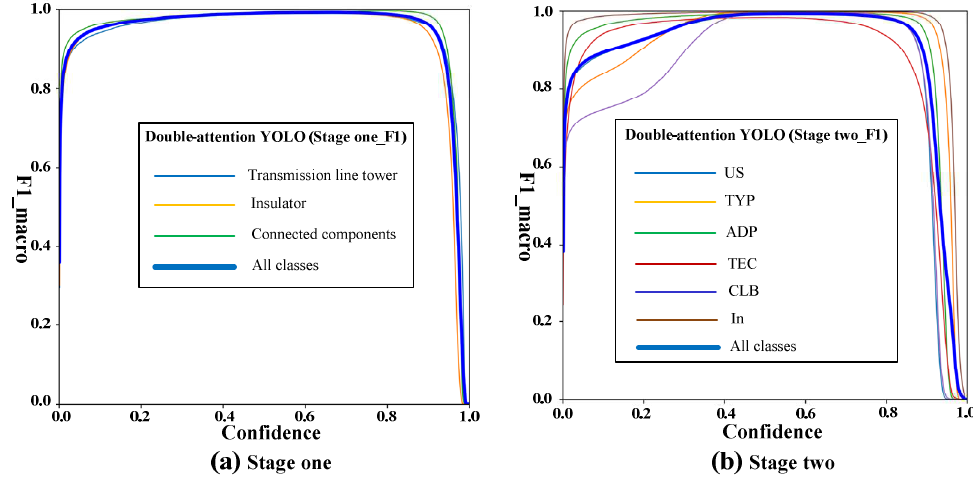
Figure 18. The results of macro-F1.